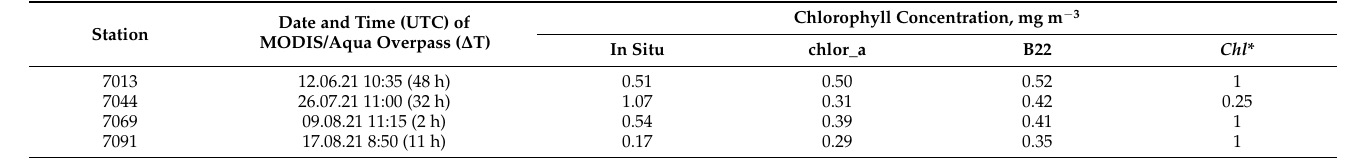
Table 3. Chlorophyll concentrations calculated based on satellite data by various algorithms (chlor_a, B22) and measured in situ.